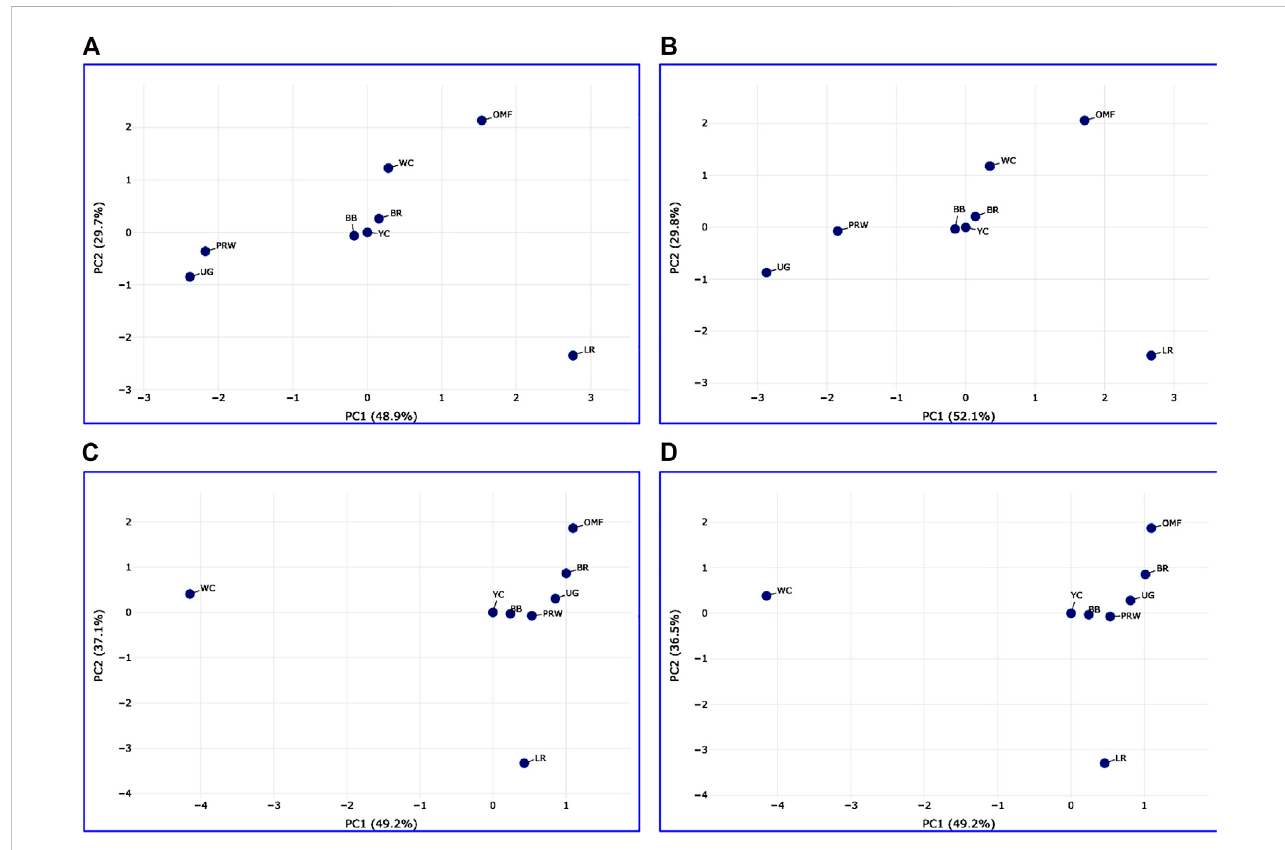
FIGURE 3 PCA plots generated using the Phantasus tool (Zenkova et al., 2018) and the data Type IIIa (A,C) and IIIb (B,D) as inferred for the eight studied breeds and seventestedmyogenesisassociatedgenesexpressedinthebreast (A,B) andthigh (C,D) muscles. X and Y